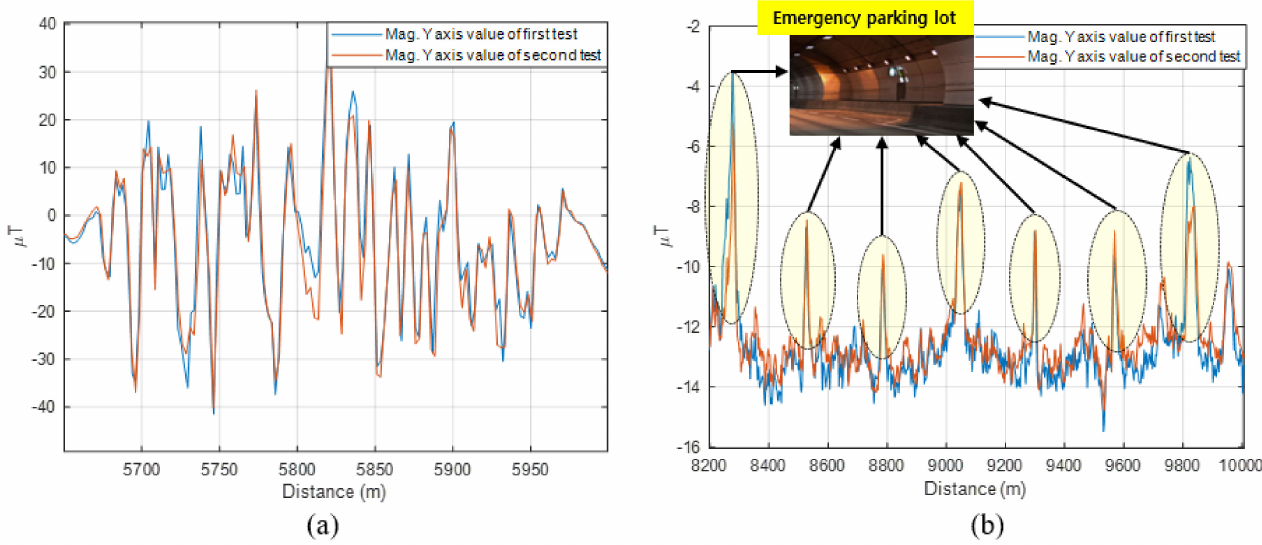
Figure 5. Magnetic field values of repeated experiments in the tunnel. ( a ) high repeatability, ( b ) recurrence of a specific